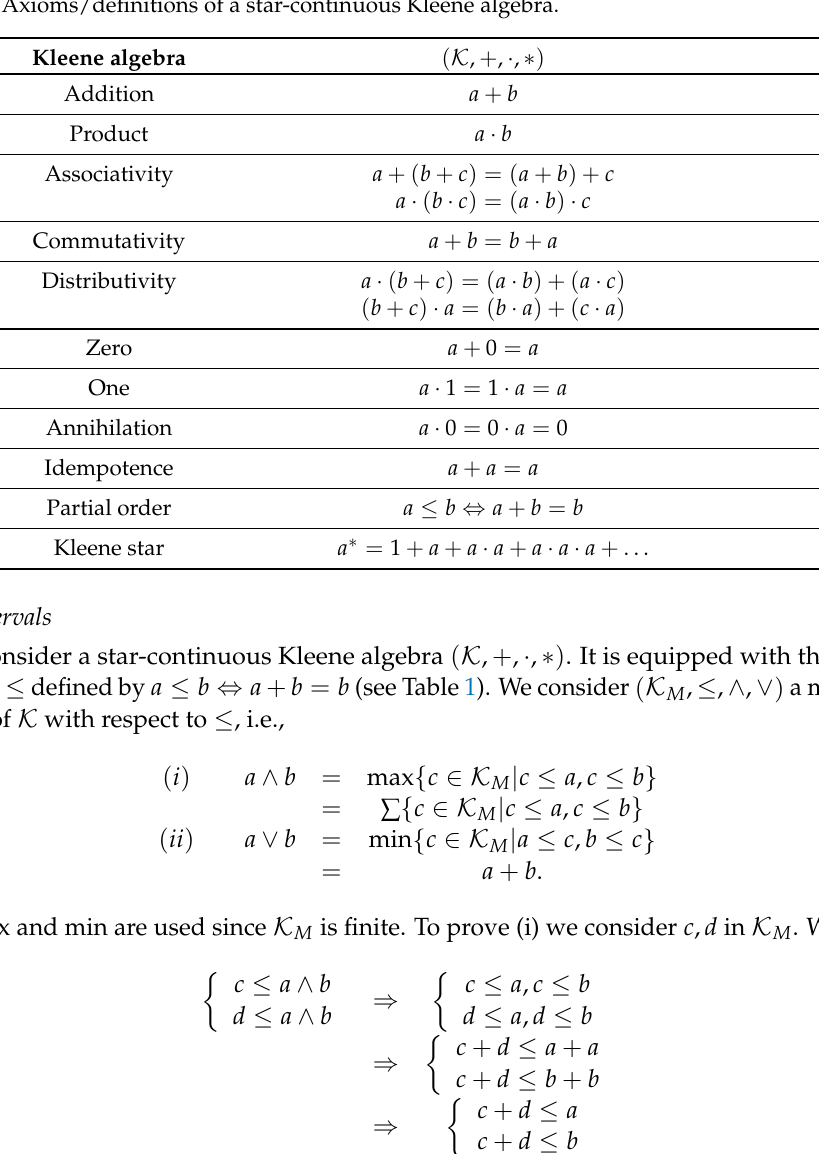
Table 1. Axioms/definitions of a star-continuous Kleene